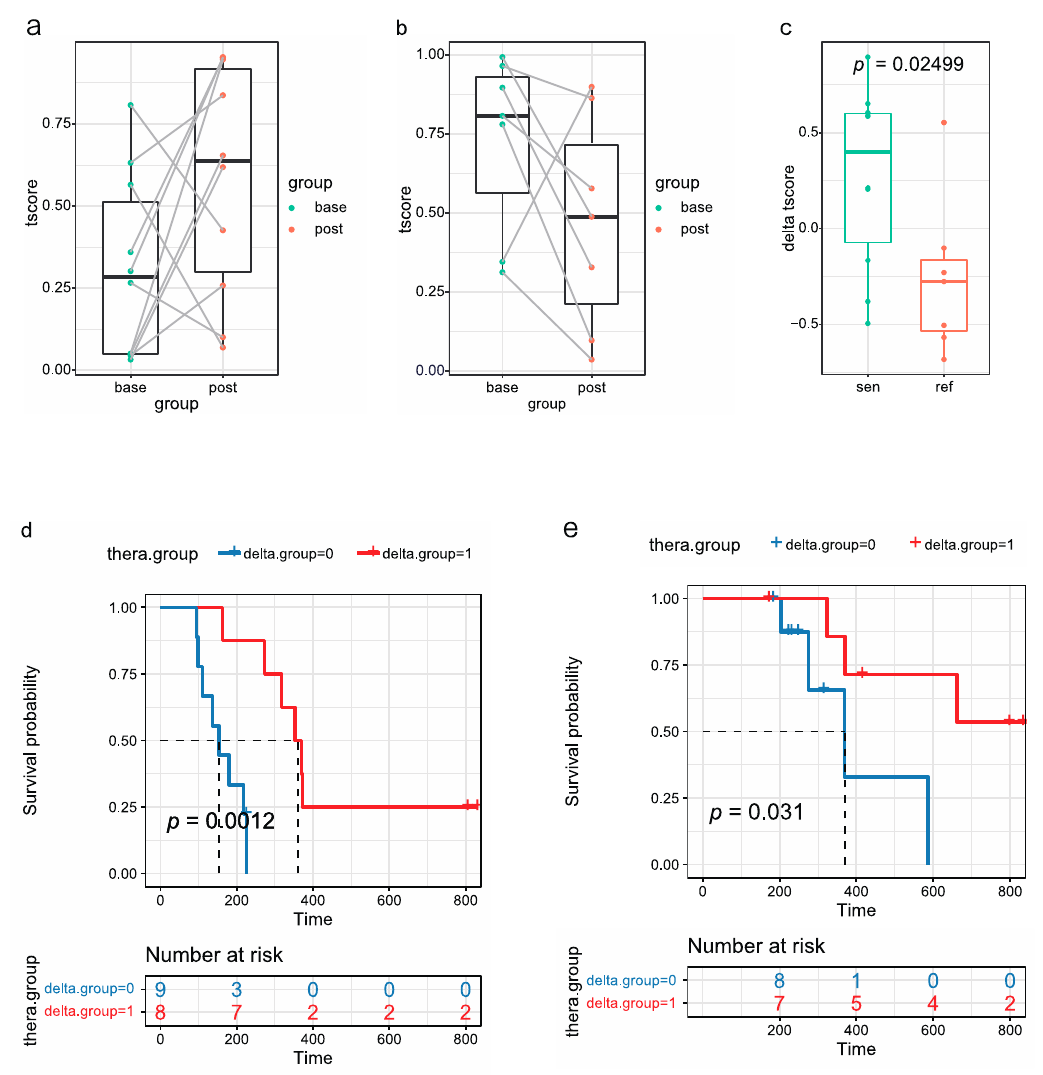
Figure 5. T-scores of paired samples at baseline and after 2 courses of chemotherapy. T-scores of chemo-sensitive ( a ) and chemo-refractory ( b ) groups at baseline and after 2 courses of chemotherapy. ( c ) T-score difference in chemo-sensitive and chemo-refractory groups. Kaplan–Meier survival analysis (log-rank test) of PFS ( d ) and OS ( e ) of SCLC patients with high and low t-score differences.